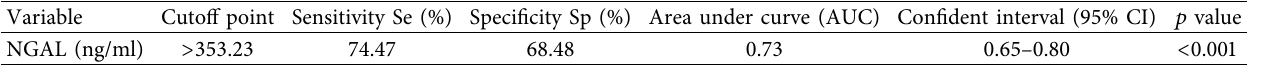
Table 2: Cutoff point, sensitivity, specificity, and AUC of NGAL diagnosing CRS1. Variable